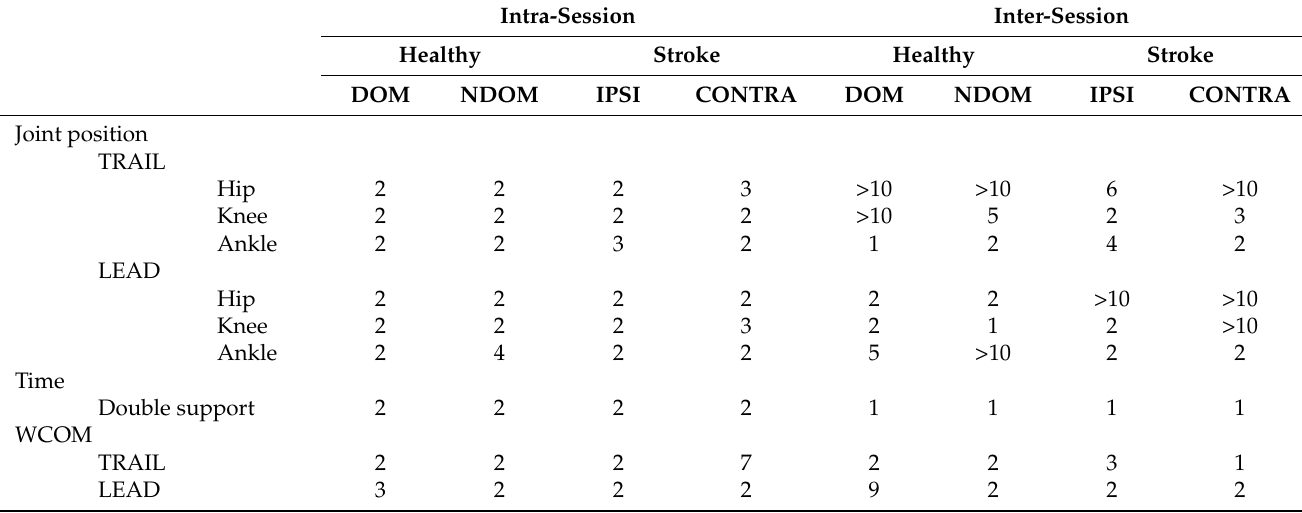
Table 3. Number of trials needed to reach good performance stability intra-session and inter-session (ICC > 0.75) of the kinematic variables (hip, knee, and ankle joint position) and kinetics (work on the centre of mass) with the dominant lower limb (healthy)/ipsilesional (stroke) in the TRAIL and LEAD